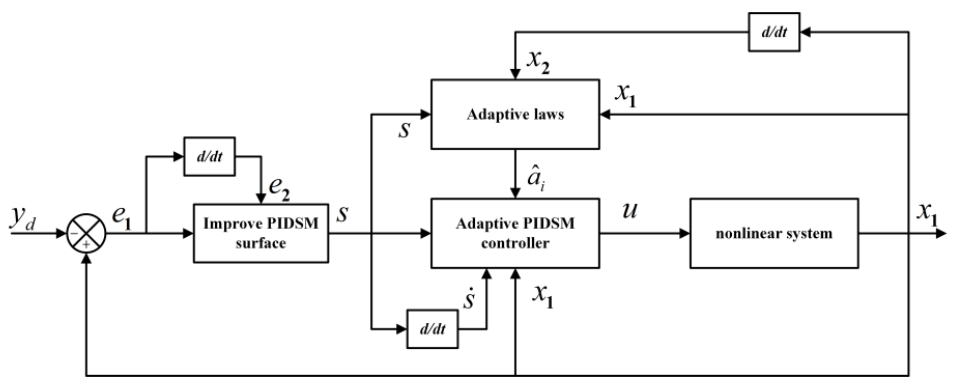
Figure 2. Control diagram of the designed controller.